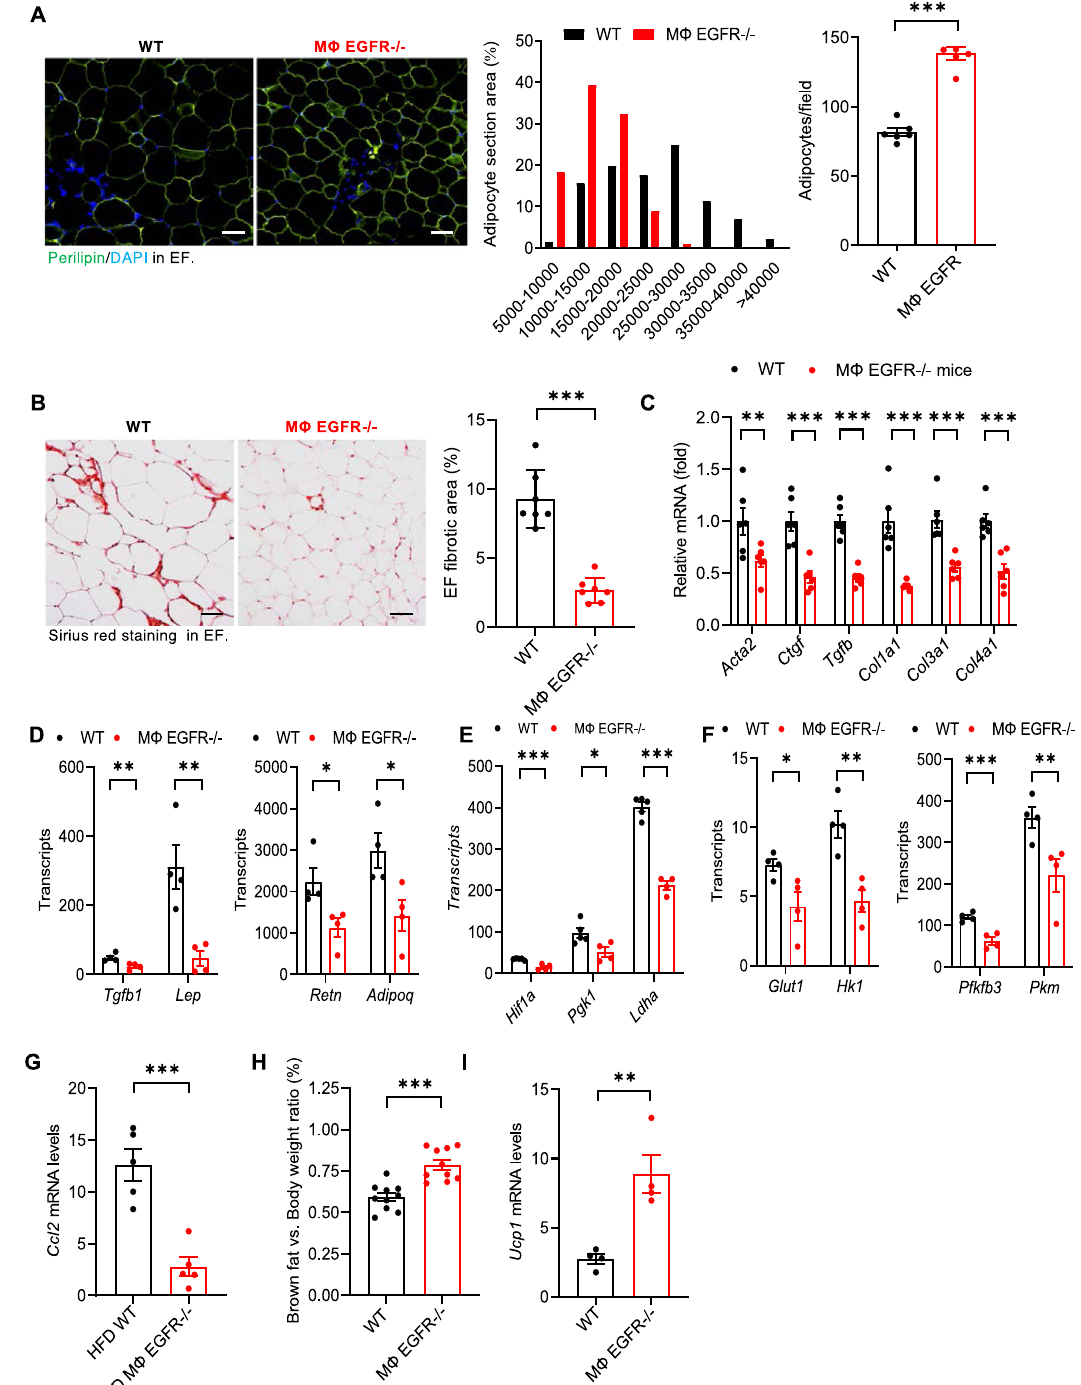
Fig. 5 | Myeloid EGFR − / − mice had reduced adipocyte hypertrophy and adipose tissueadipokines,glycolysis,hypoxia,and fi brosisinresponsetotheHFD. WT and M Φ EGFR − / − mice were fed the HFD for 12 weeks. A Image analysis of perilipin immuno fl uorescenceshowedsmallerbutincreasedadipocytesinEFinM Φ EGFR − / − mice than WT mice. N =10, scale bar=100 μ m. B Quantitative Sirius Red staining indicated less fi brosis in EF in M Φ EGFR − / − mice than WT mice. N =6, scale bar= 100 μ m. C – G M Φ EGFR − / − mouse EF had lower pro fi brotic and fi brotic genes including Acta2 , Ctgf , Tgfb1 , Col1a1 , Col3a1 , and Col4a1 , n =6 C , lower adipokine